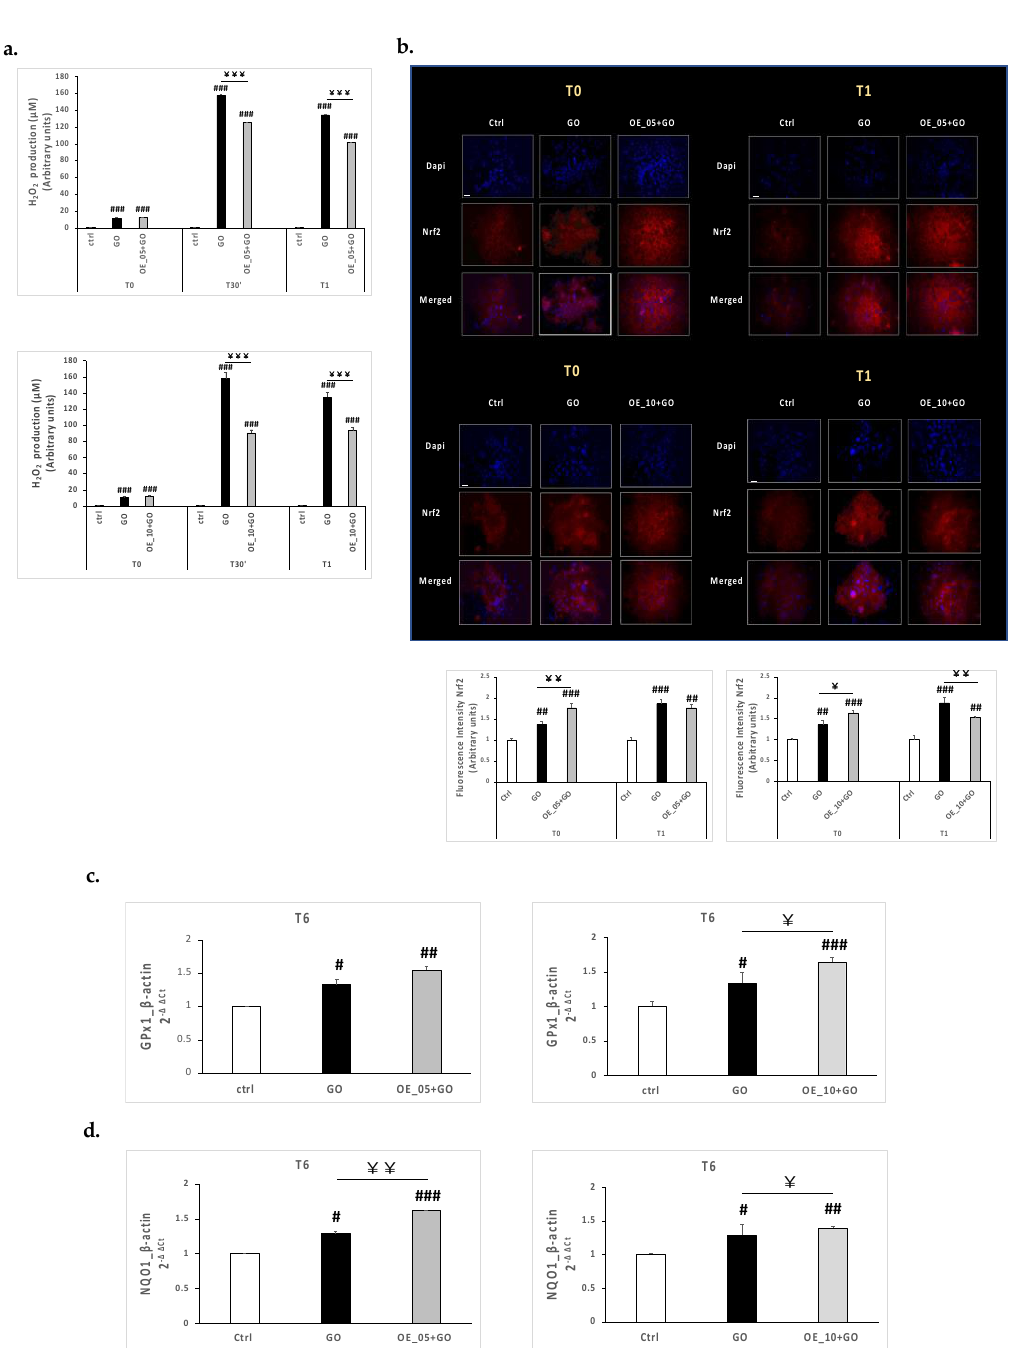
Figure 4. ( a ) H 2 O 2 levels in media of CaCo-2 cells treated with 20 μ g/mL OE_05 or OE_10 for 24 h and exposed to GO 0.5 U/mL for 1 h (T0, T3 0′ , T1). ( b ) Immunofluorescence staining of DAPI (blue) and Nrf2 (red), 0 and 1 h post-GO exposure in CaCo-2 cells pre-treated with 20 μ g/mL of OE_05 or OE_10 for 24 h. Original magnification at 40x; scale bar = 40 μ m. The immunofluorescent signal was semiquantified by using ImageJ software (National Institutes of Health, Bethesda, MD) and the quantification graphs are displayed in the bottom panel. Transcript levels of GPx1 ( c ) and NQO1 ( d ) measured using qRT-PCR 6 h post-GO exposure in CaCo-2 cells pre-treated with EVOO extracts for 24 h. Data are the results of the averages of at least three different experiments, # p < 0.05, ## p < 0.01, ### p < 0.001 GO ± OE_05 or OE_10 vs. ctrl and ¥ p < 0.05, ¥¥ p < 0.01, ¥¥¥ p < 0.001 GO + OE_05 or OE_10 vs. GO as assessed by one-way